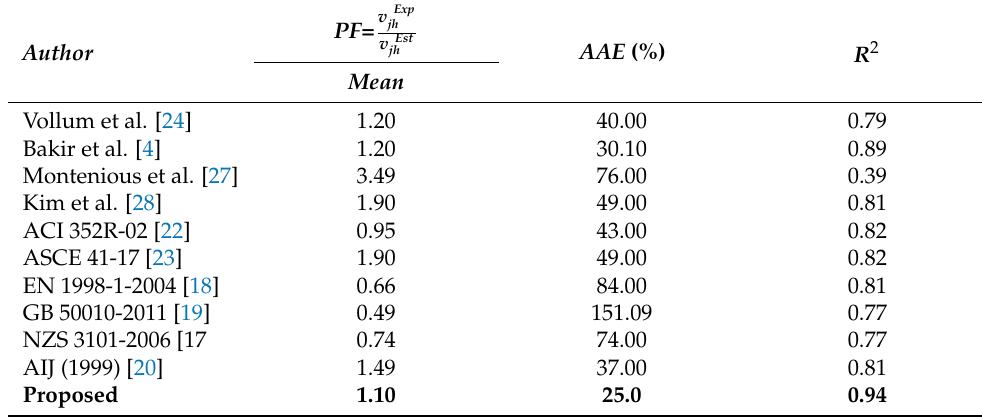
Table 4. Statistical calculations of the reinforced RC exterior